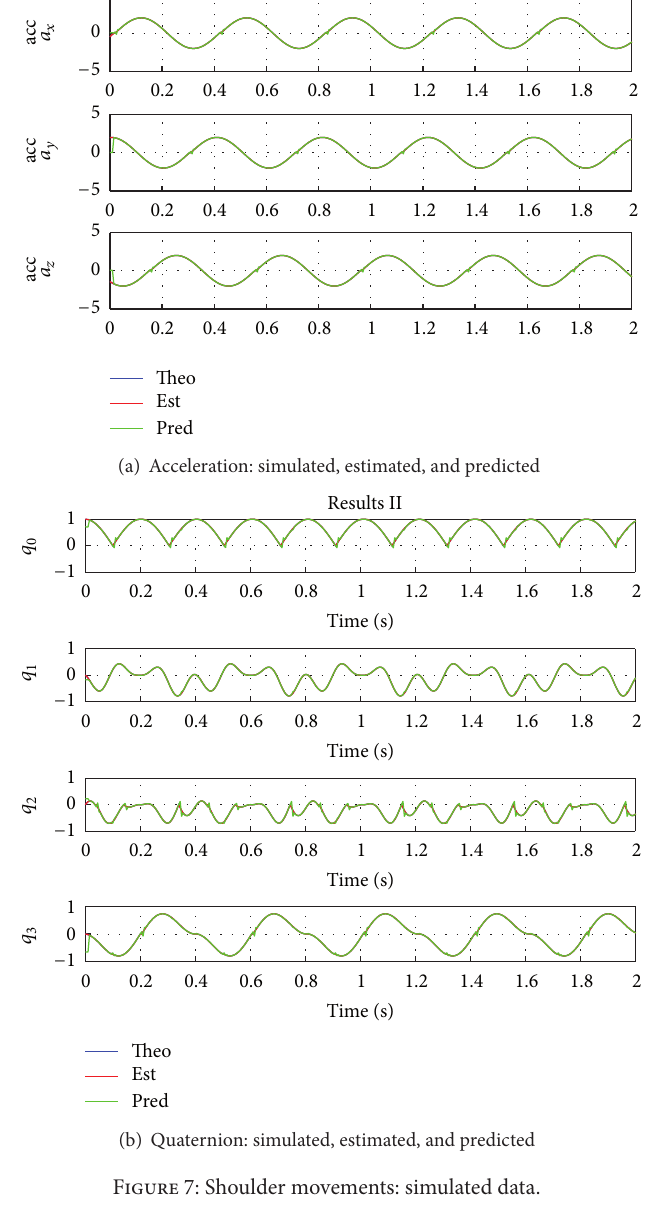
(b) Quaternion: simulated, estimated, and predicted Figure 7: Shoulder movements: simulated